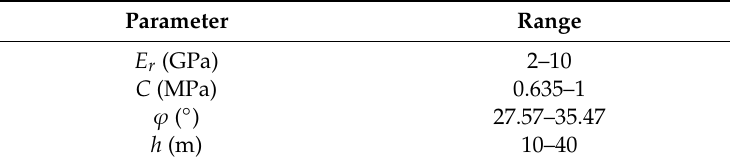
Table 5. Parameters and their values in parametric analyses [23–25].